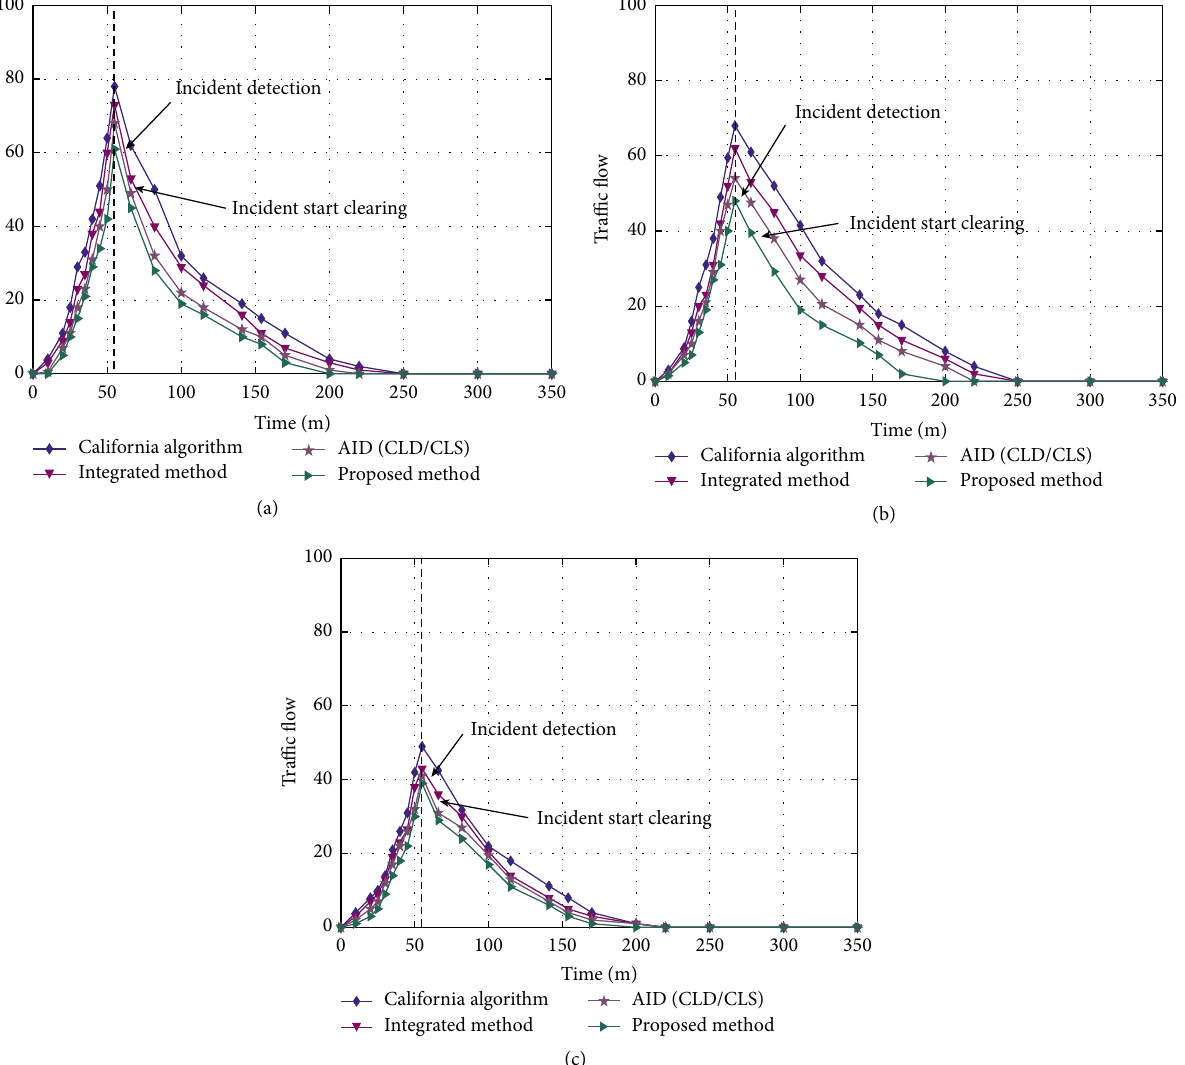
Figure 8: Shows the comparison of the proposed method with California algorithm, integrated algorithm, and AID (CLD/CLS) method with three different cases. (a) Heavy traffic congestion, (b) moderate traffic congestion, and (c) less traffic